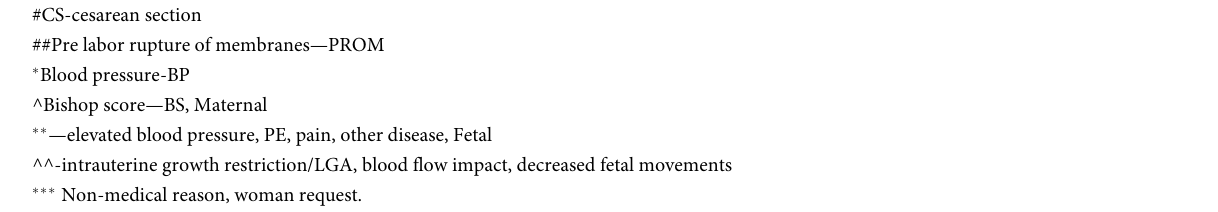
significant difference was seen regarding Apgar < 7 at 5 min or cord blood pH < 7.10 (Table 3). The associations between the different risk factors for CS and IOL are presented in Table 4.